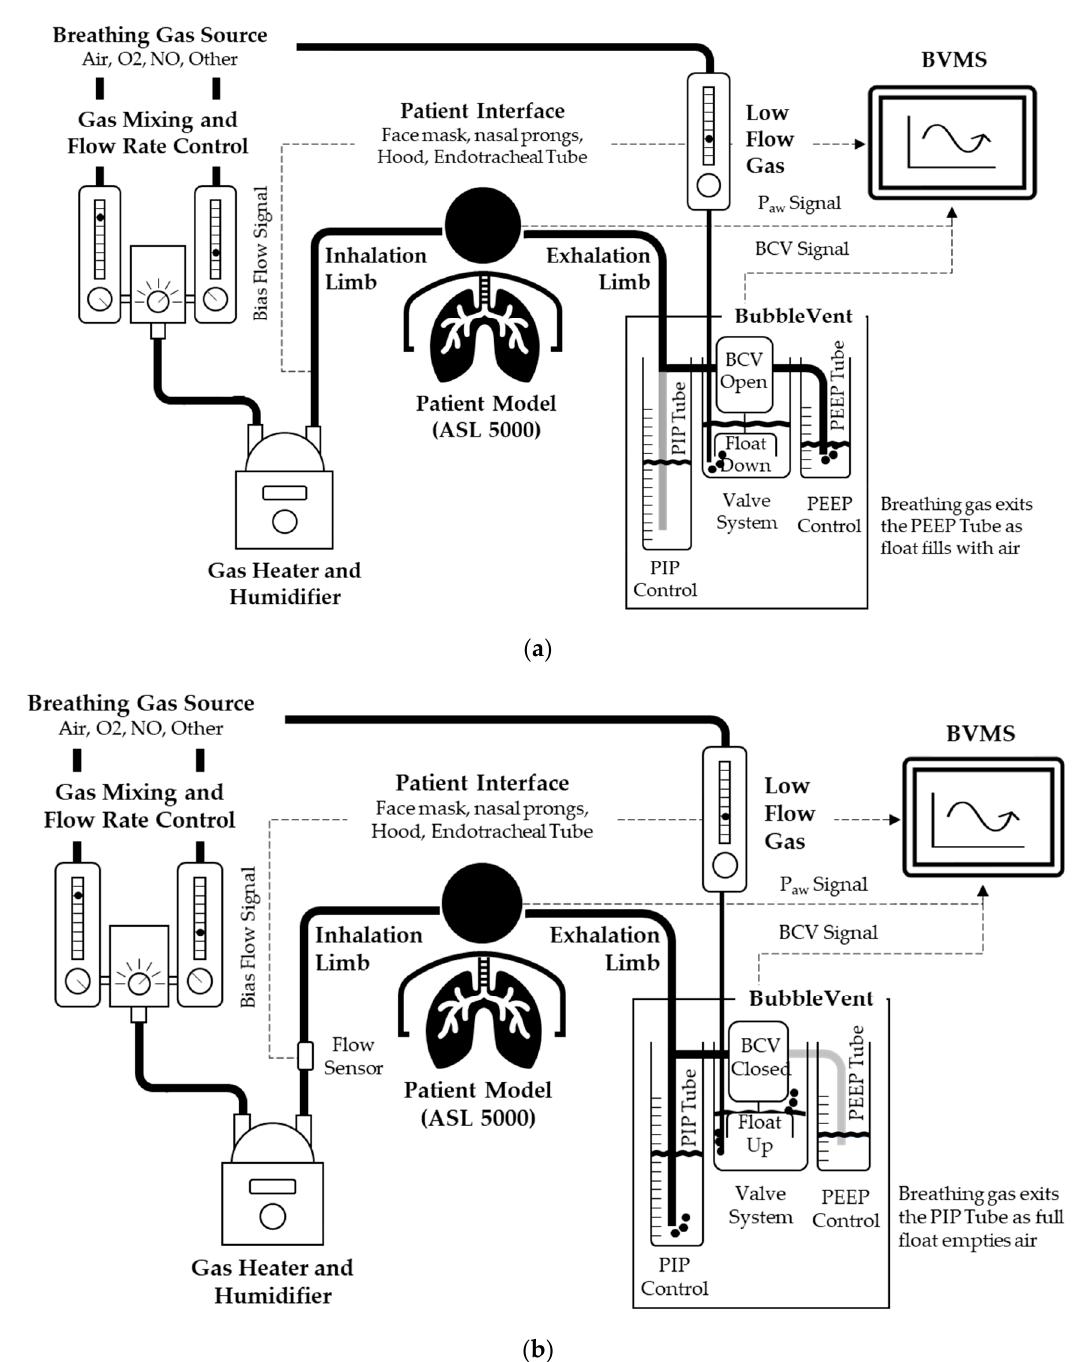
Figure 1. A schematic of the BubbleVent system including the directional characteristics of gas flow during inhalation and exhalation phases. ( a ) Exhalation Phase/B ‐ CPAP mode: PEEP is delivered to the patient model; the BCV mechanism is open; gas is entering the float. ( b ) Inhalation phase: PIP is delivered to the patient model; the BCV is closed; gas is exiting the